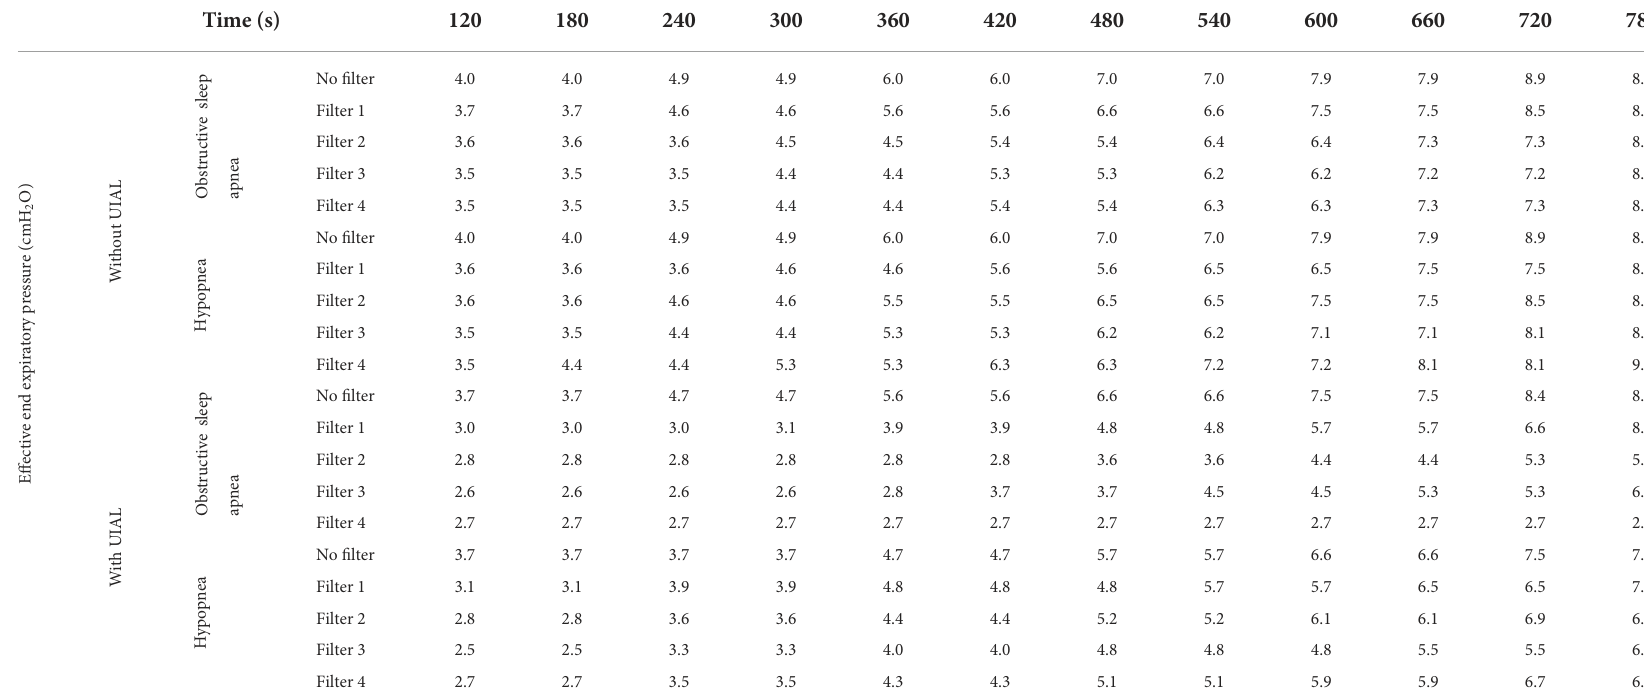
TABLE 2 Pressure variation in APAP mode during simulated respiratory